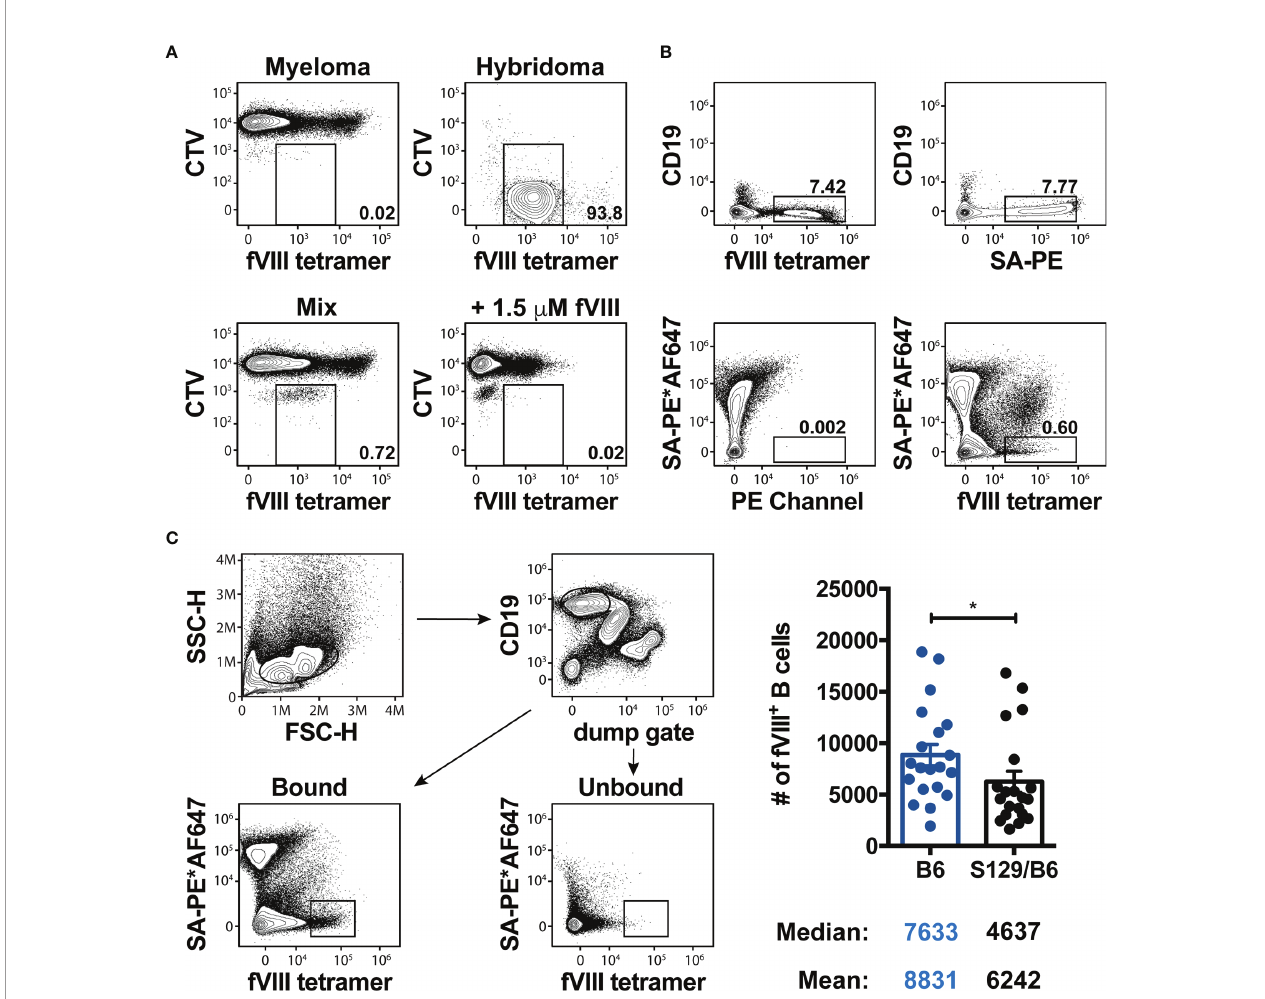
FIGURE 2 | Precursor frequency of FVIII reactive B cells is slightly lower in S129/B6 FVIII de fi cient mice. (A) Representative contour plots illustrating the speci fi city of the FVIII B cell tetramer. 20,000 Cell Trace Violet (CTV) labeled hybridomas expressing a BCR reactive to FVIII were mixed with 2 x 10 6 myeloma cells (fusion partner) that express an invariant BCR. Samples were then incubated with IMDM media or 1.5 m M full-length FVIII 10 minutes prior to the FVIII B cell tetramer. Flow cytometry was utilized to detect CTV + hybridomas expressing a BCR speci fi c to FVIII. (B) Representative fl ow cytometric analysis of B cells in a fraction enriched using anti-PE magnetic microbeads after staining with the FVIII B cell tetramer, SA-PE and/or the SA-PE*AF647 non-speci fi c tetramer. (C) Gating strategy and graphical demonstration of the precursor frequency of FVIII speci fi c B cells. Splenocytes and peripheral lymph nodes were harvested from naïve B6 and S129/B6 FVIII de fi cient mice, and subsequently enriched and quanti fi ed using the FVIII B cell tetramer. Error bars represent ± SEM. Statistics were generated using an unpaired Mann-Whitney test. There were 20 mice per group in panel (C) . Results illustrated are representative of 2-3 experiments (A, B) or combined data from 20 experiments (C) . *p <